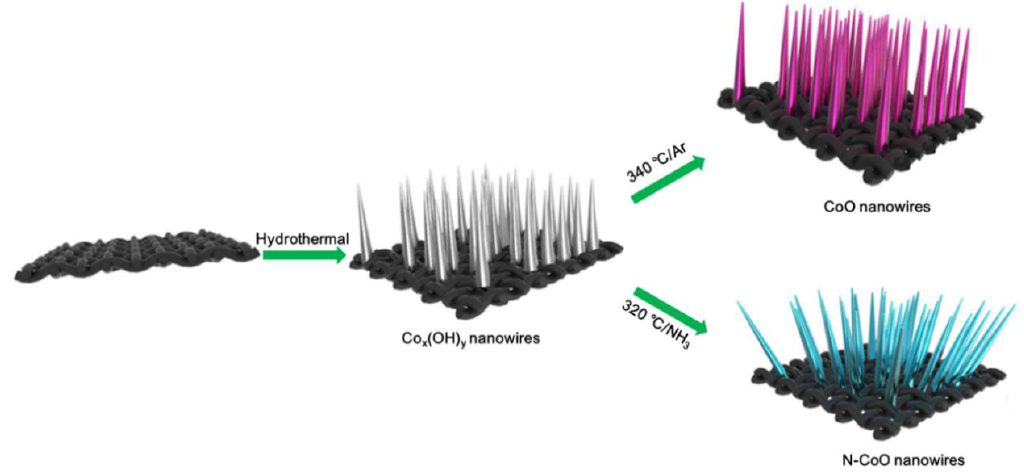
Figure 1. The schematic illustration for the preparation of CoO and N-CoO nanowires.